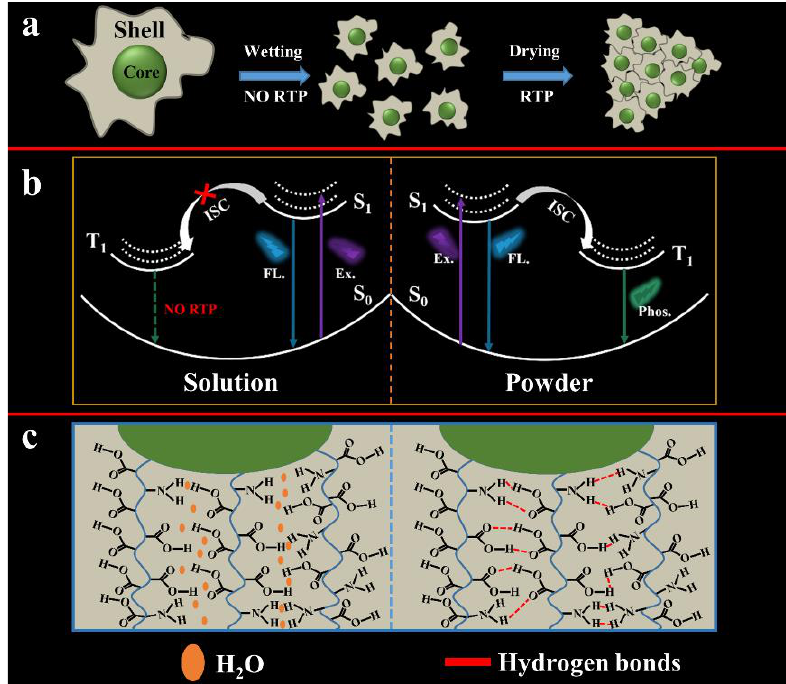
Figure 6. Mechanism of the photophysical processes of AA-CPDs. ( a ) Schematic of the process for achieving RTP; ( b ) The phosphorescence emission process of AA-CPDs; ( c ) Schematic diagram of hydrogen bond network interactions between AA-CPDs.